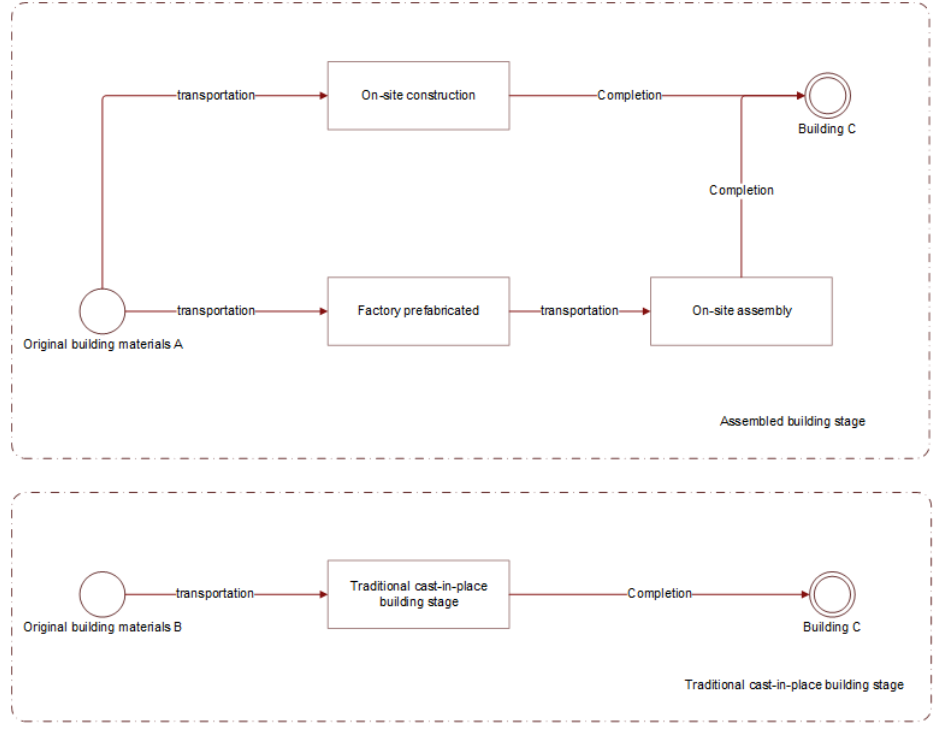
Figure 1. Comparison of assembled and cast-in-place construction processes.